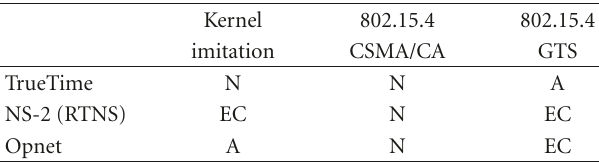
Table 1: Comparison among simulation packages. N = Native, A = Absent, EC = External Contribution.